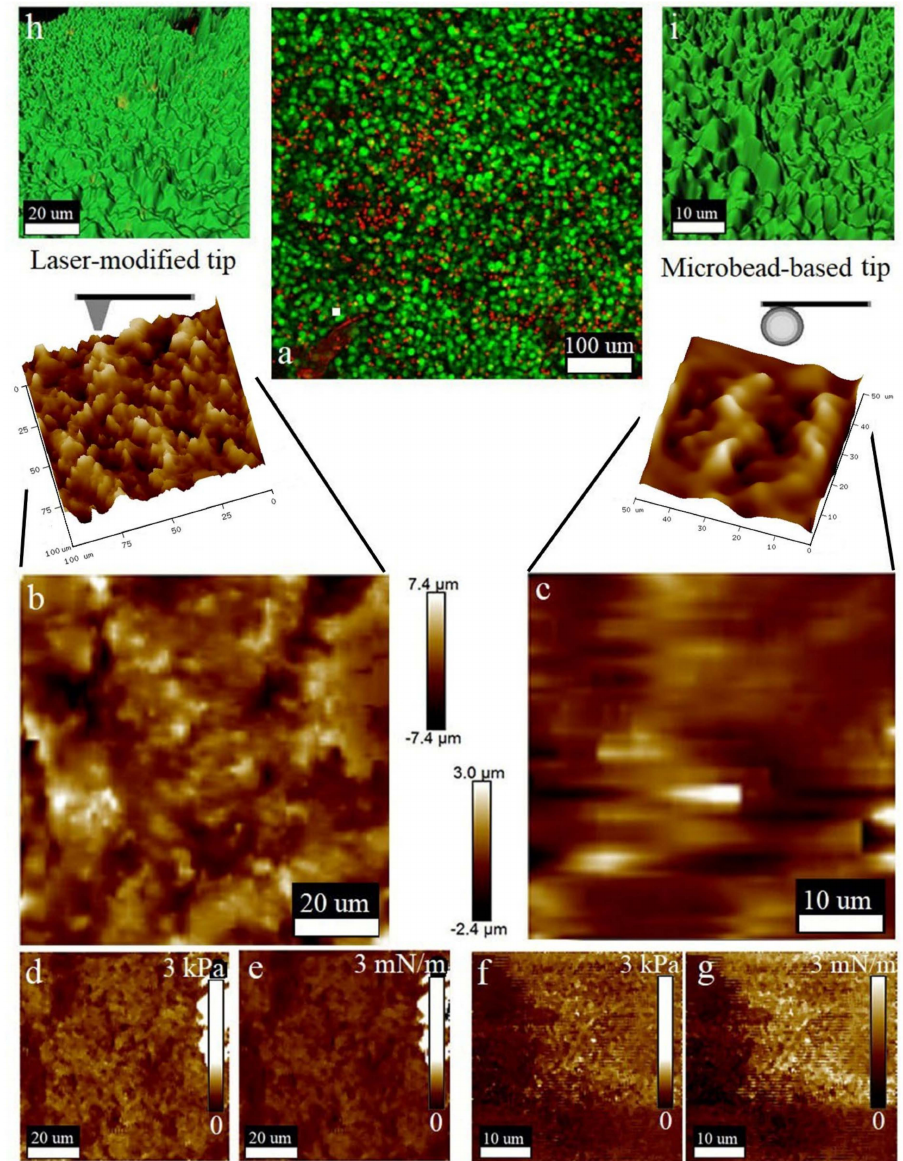
Figure 5. Surface properties of the human glioma slice studied by LSM ( a , h , i ) and AFM (laser- reshaped ScanAsyst Fluid High Resolution probe ( b , d , e ) and microbead − based cantilevers NP − 10 ( c , f , g ). ( a ) Large-scale LSM map showing the ratio of live (green glow) to dead cells (red glow). ( h , i ) Two areas show 3D reconstruction of the smaller map sections chosen for subsequent AFM studies with two types of cantilevers. Surface morphology of the chosen slice obtained using laser-reshaped ( b ) and microbead − based ( c ) cantilevers. Insets on both images provide 3D reconstructions of these areas. ( d , e ) Elasticity and stiffness AFM maps of the chosen areas by laser-reshaped ScanAsyst Fluid High Resolution probe. ( f , g ). Elasticity and stiffness AFM maps by microbead-based cantilevers NP −